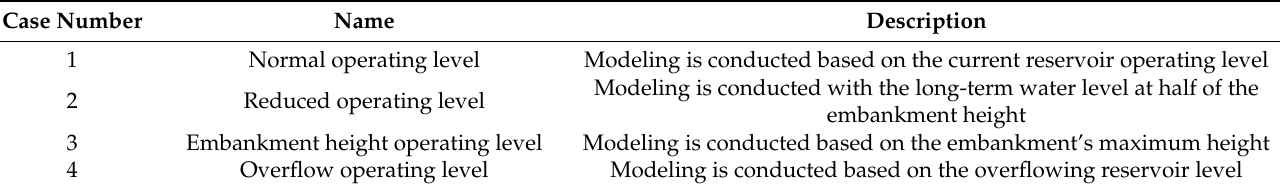
Table 2. Cases used in the investigation process.